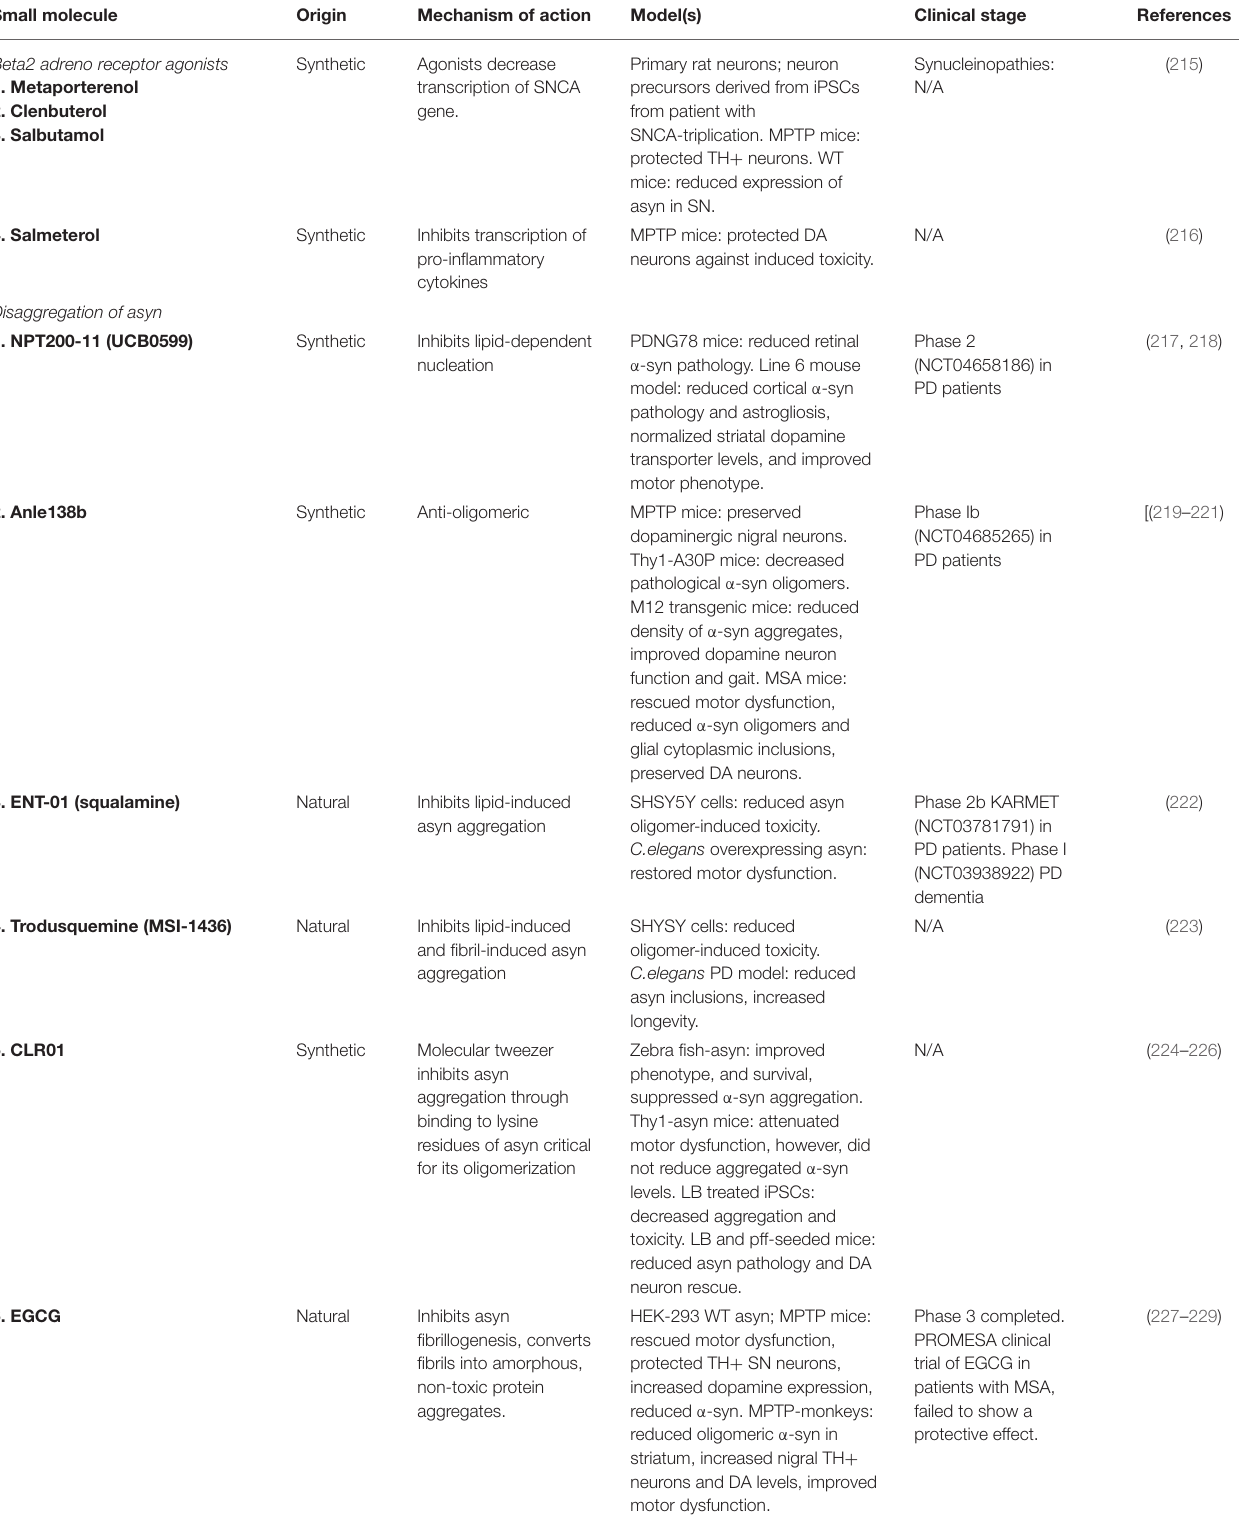
TABLE 3 | Pharmacological approaches to reduce asyn. Small